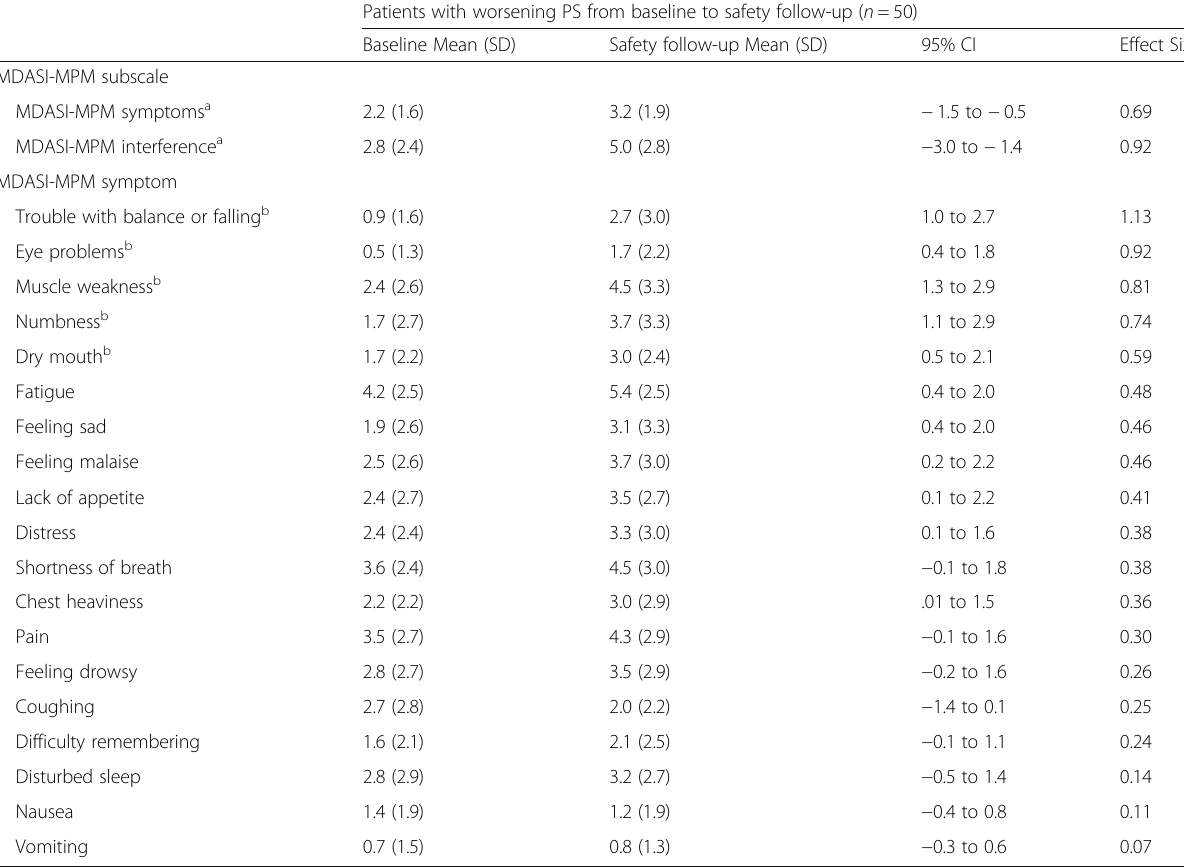
Table 5 Sensitivity of the MDASI-MPM based on changes in ECOG Performance Status (PS) Patients with worsening PS from baseline to safety follow-up ( n = 50) Baseline Mean (SD) Safety follow-up Mean (SD) 95% CI Effect